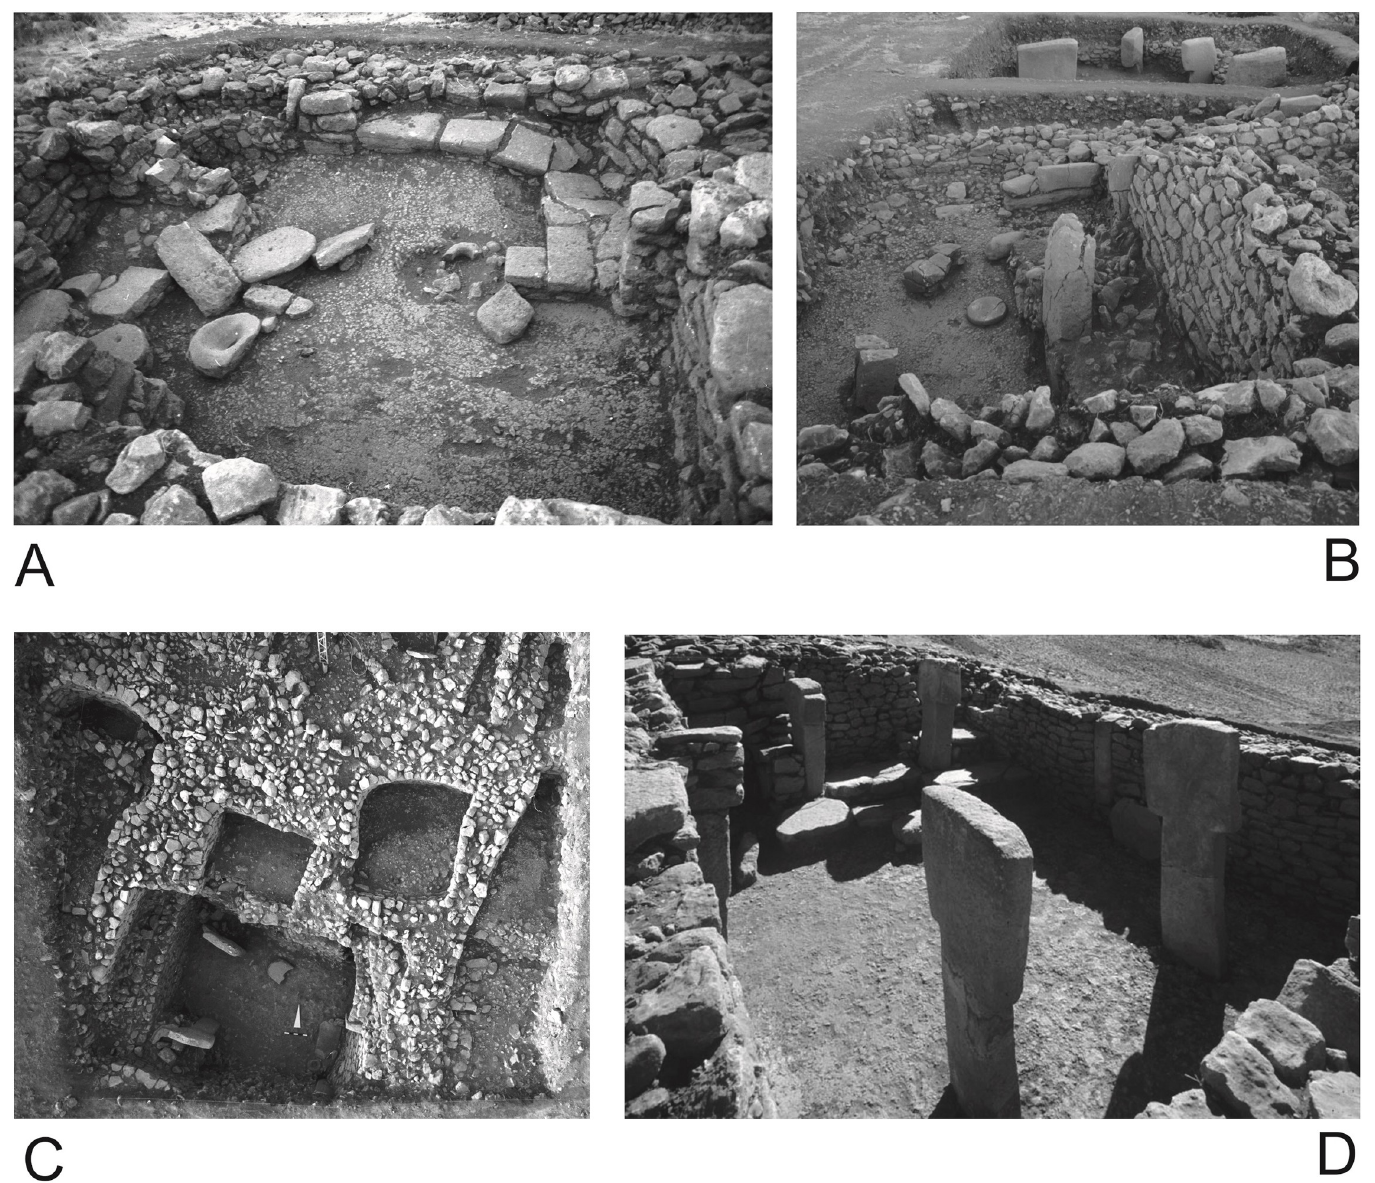
Fig 3. Go¨bekli Tepe, rectangular buildings of layer II in the main excavation area. (A) Building 25 with grinding bowl on the floor and benches; (B) building 9 with pillars and plate; (C) building 16 with three cell-like adjacent rooms; (D) building 38 (the lion-pillar building (German Archaeological Institute, photos K. Schmidt).